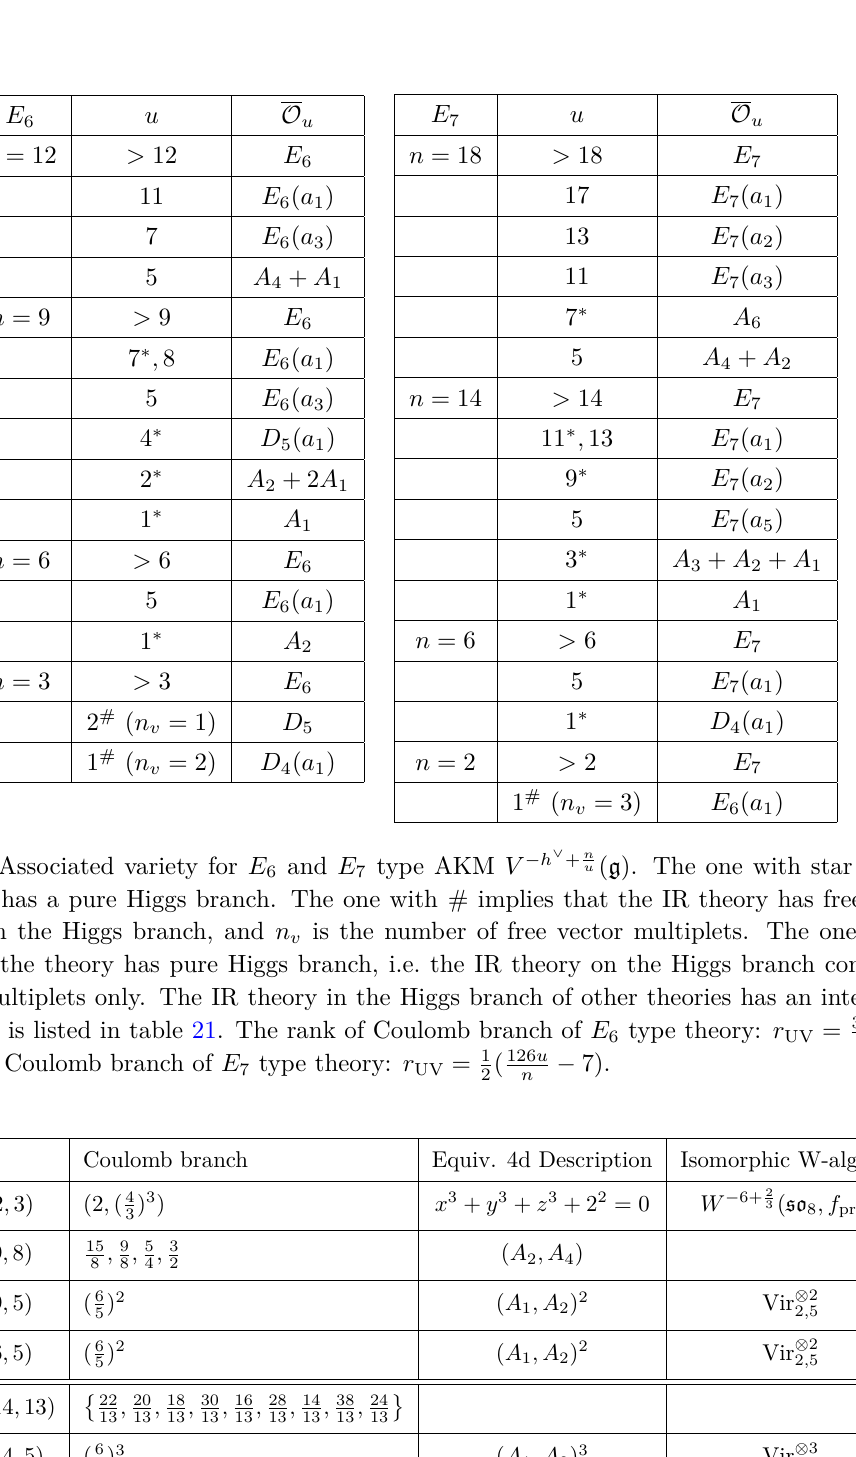
( g , f ) . Last two columns (if any) are u